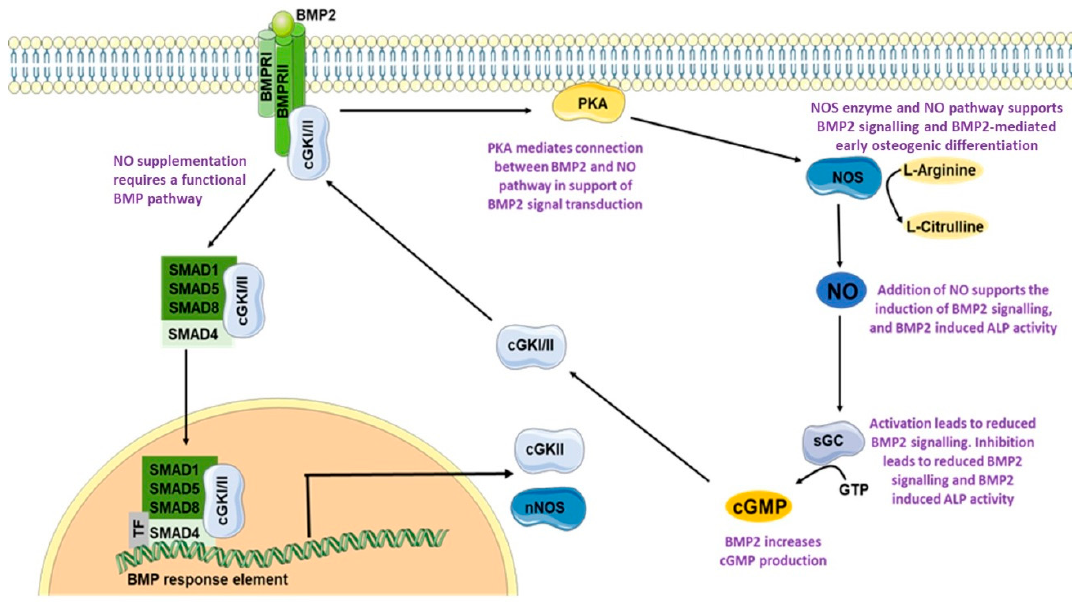
Figure 12. Graphical summary of perceived crosstalk of BMP2-mediated signaling and the NO pathway. Figure image composed from graphics taken from Servier Medical Art.